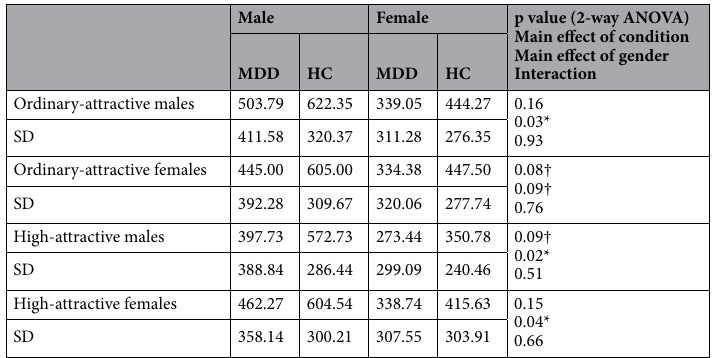
Table 2. Monetary score (trusting behaviors) for each type of photographed partner. † p < 0.10, * p <